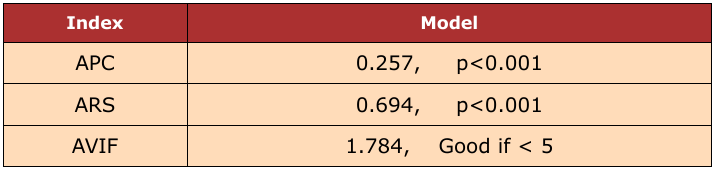
Table 2. Model fit indices and P